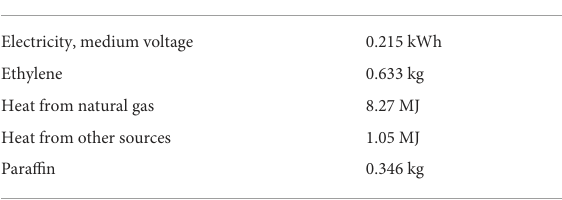
position (between the first two carbons of the respective chains) to an internal position